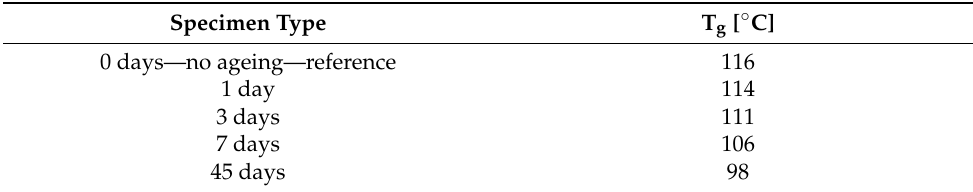
Figure 5. DMA results example—7 days aged coupons. Table 3. T g values at different ageing times .